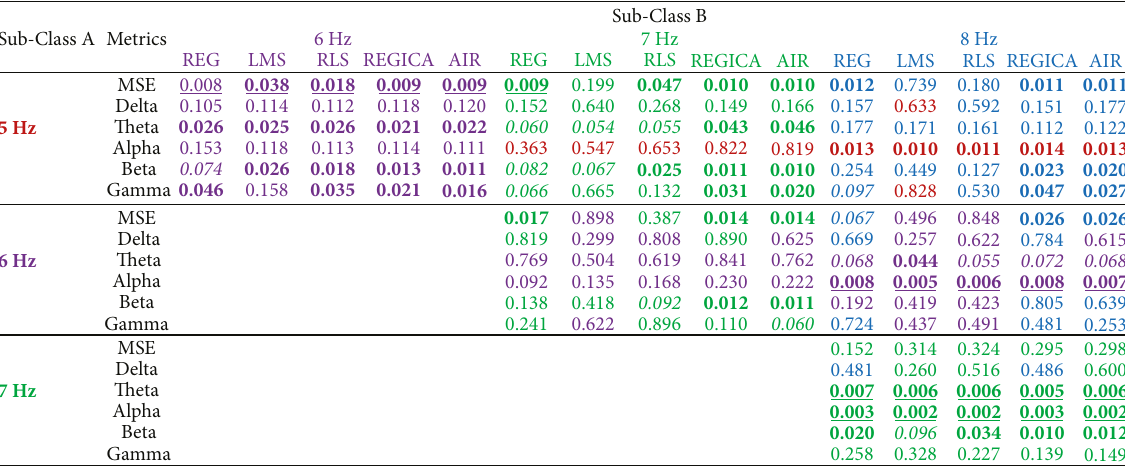
Figure 6: Statistical increases between di ff erent metrics for artifact corrections with di ff erent EOG fi ltering of best class from Figure 5 (paired t -tests were used between subclass A versus subclass B). Bold and underline: p < 0 01 ; Bold: p < 0 05 ; Italic: p < 0 1 ; Color indicate better